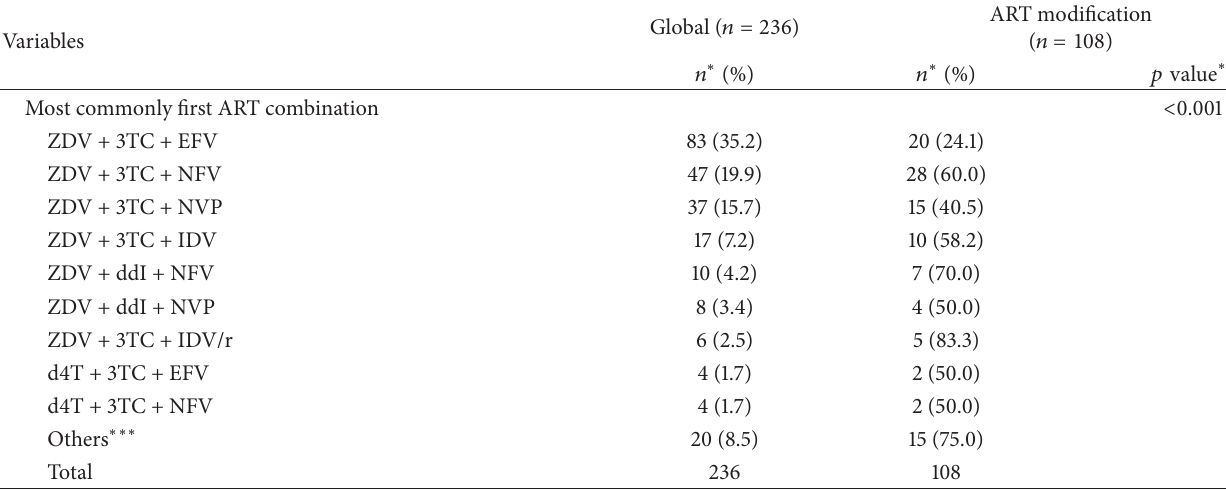
3TC: lamivudine, ART: antiretroviral therapy, d4T: stavudine, ddI: didanosine, EFV: efavirenz, IDV/r: indinavir/ritonavir, NFV: nelfinavir, NRTI: nucleoside reverse transcriptase inhibitor, and NNRTI: nonnucleoside reverse transcriptase inhibitor. NVP: nevirapine, PI: protease inhibitors, and ZDV: zidovudine. ∗ Missing values were not shown. ∗∗ Pearson’s chi-square test.